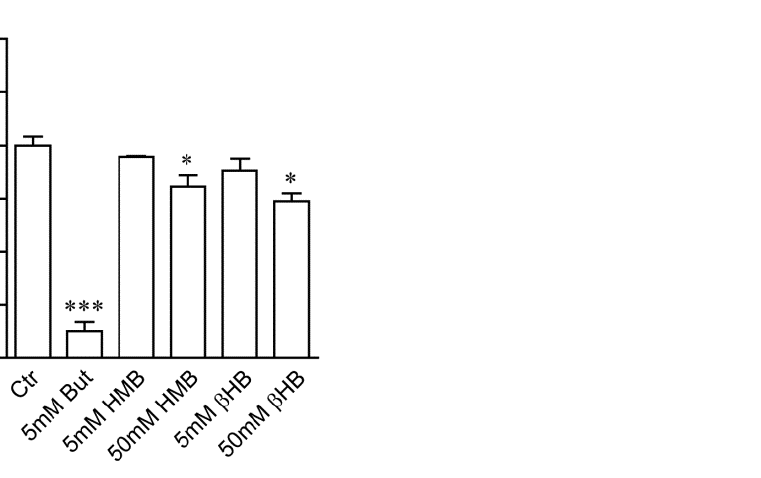
Figure 2. In vitro HDAC activity assay performed in the presence of the indicated concentrations of putative inhibitory compounds, or vehicle alone (Ctr). Deacetylation of the chromogenic substrate by HeLa cell crude nuclear extract was carried out for 20 min at RT and color development quantified by an ELISA microplate reader at 405 nm. Values are in absorbance units relative to the Ctr sample, set as 100% HDAC activity. Columns are mean ± SEM of three independent experiments. * p < 0.05; *** p < 0.001 versus Ctr. But: Butyrate; HMB: β -Hydroxy- β -Methyl Butyrate; β HB: β -Hydroxybutyrate.